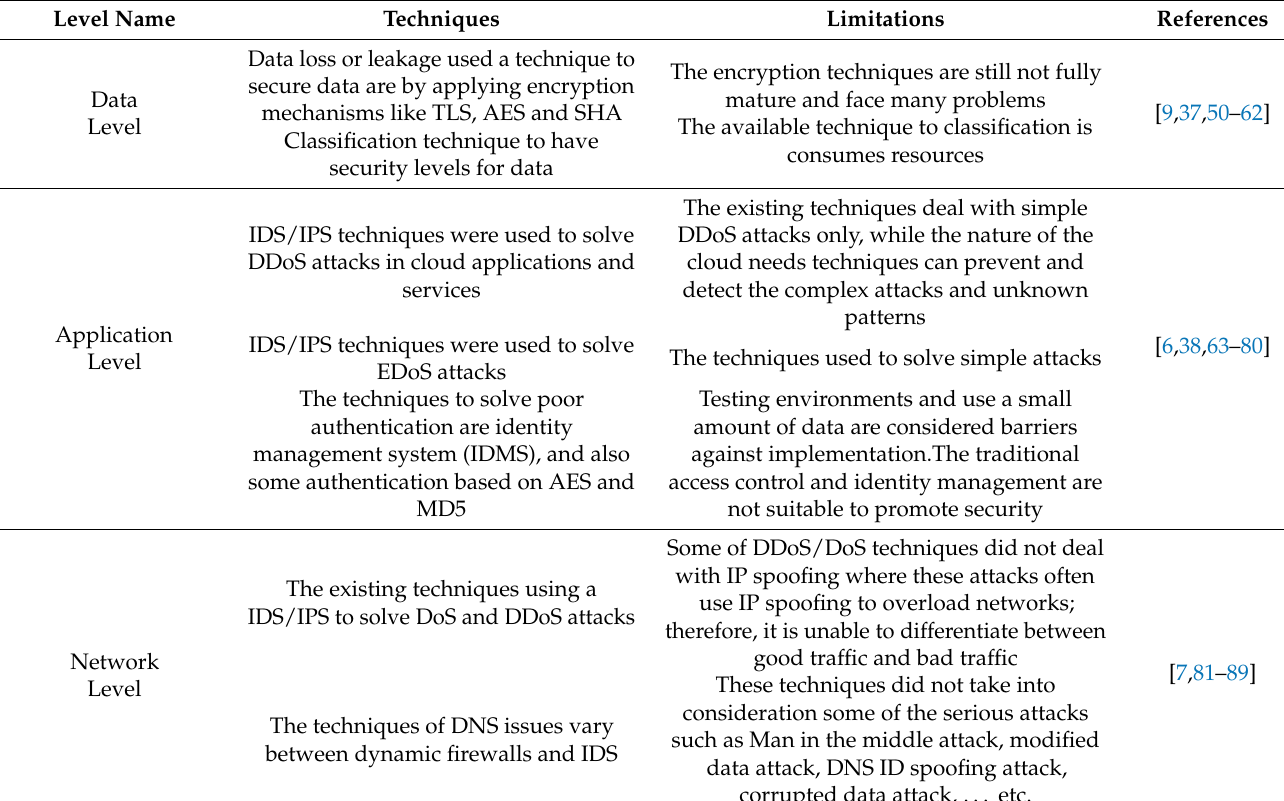
Table 4. Summary of existing solutions in the